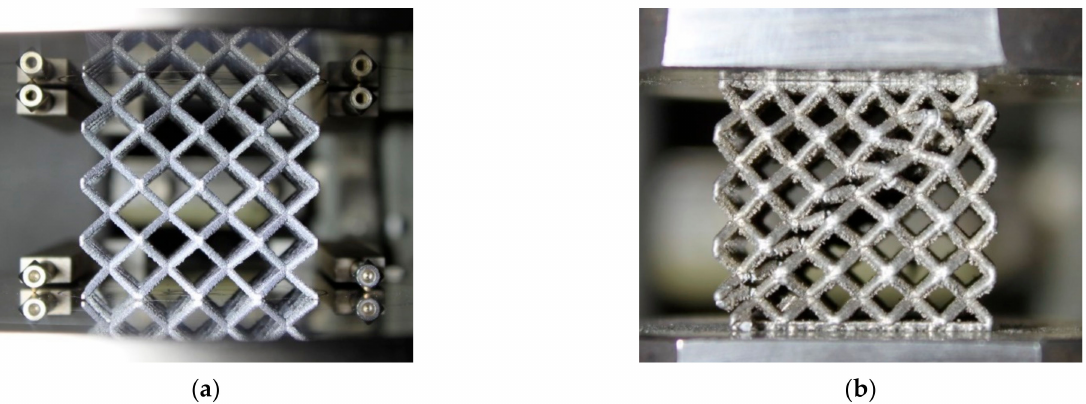
Figure 3. ( a ) The principle of the displacement measurement during the compression test. ( b ) Collapse phase of the BCC lattice structure during the compression